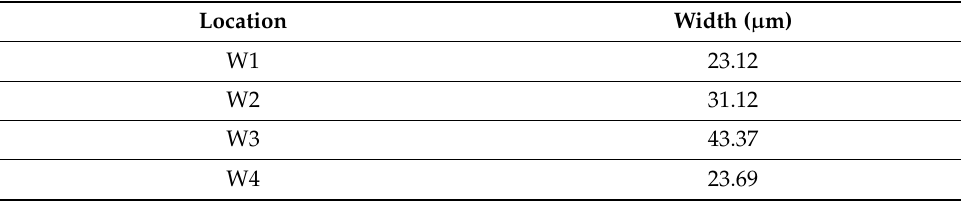
Table A2. The widths of the calcite rim of sample A1 at selected